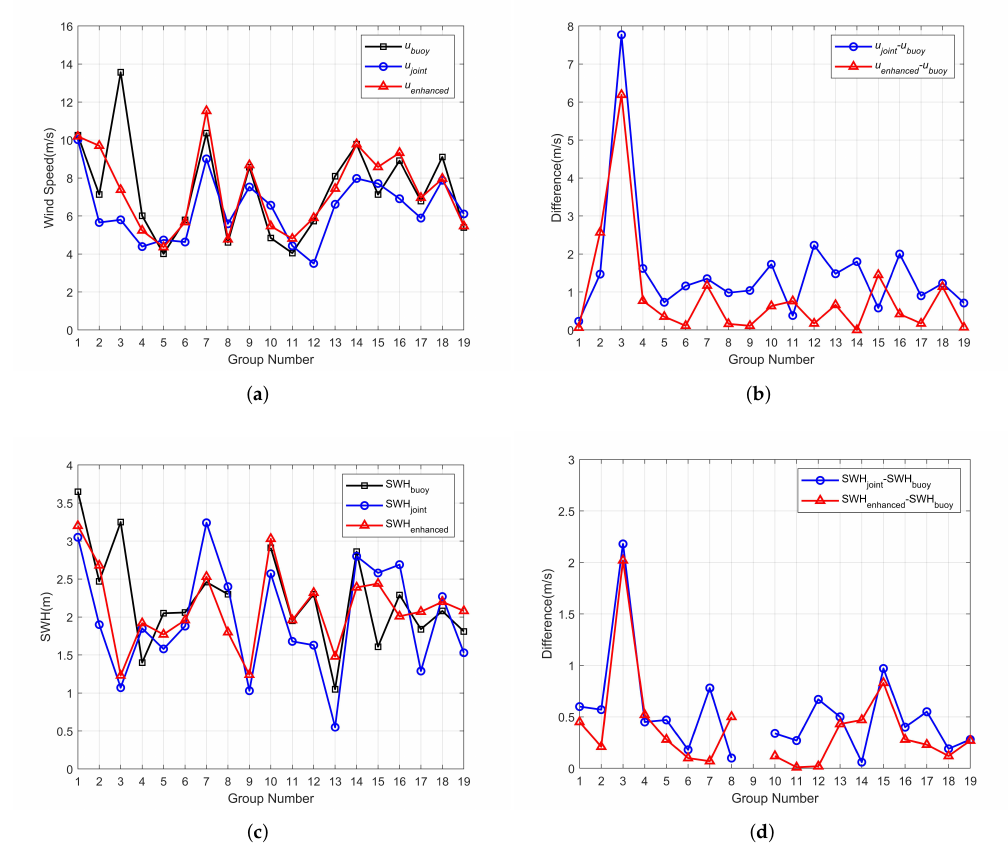
Figure 16. Comparison of the retrieved results and buoys’ data. ( a ) comparison of the joint retrieved wind speeds, enhanced wind speeds and buoy wind speeds; ( b ) difference between joint retrieved wind speeds and buoy, and enhanced retrieved wind speeds and buoy; ( c ) comparison of the joint retrieved SWHs, enhanced SWHs and buoy SWHs; ( d ) difference between joint retrieved SWHs and buoy, and enhanced retrieved SWHs and